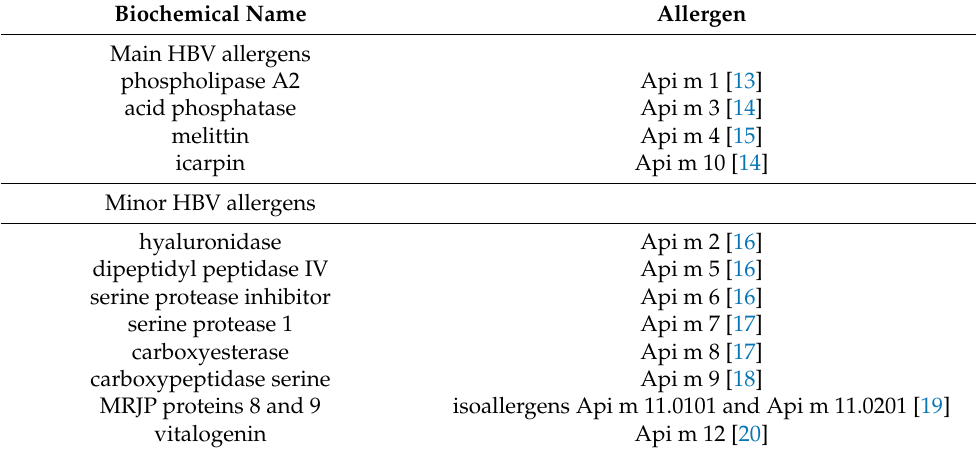
Table 1. Bee venom allergens. Biochemical